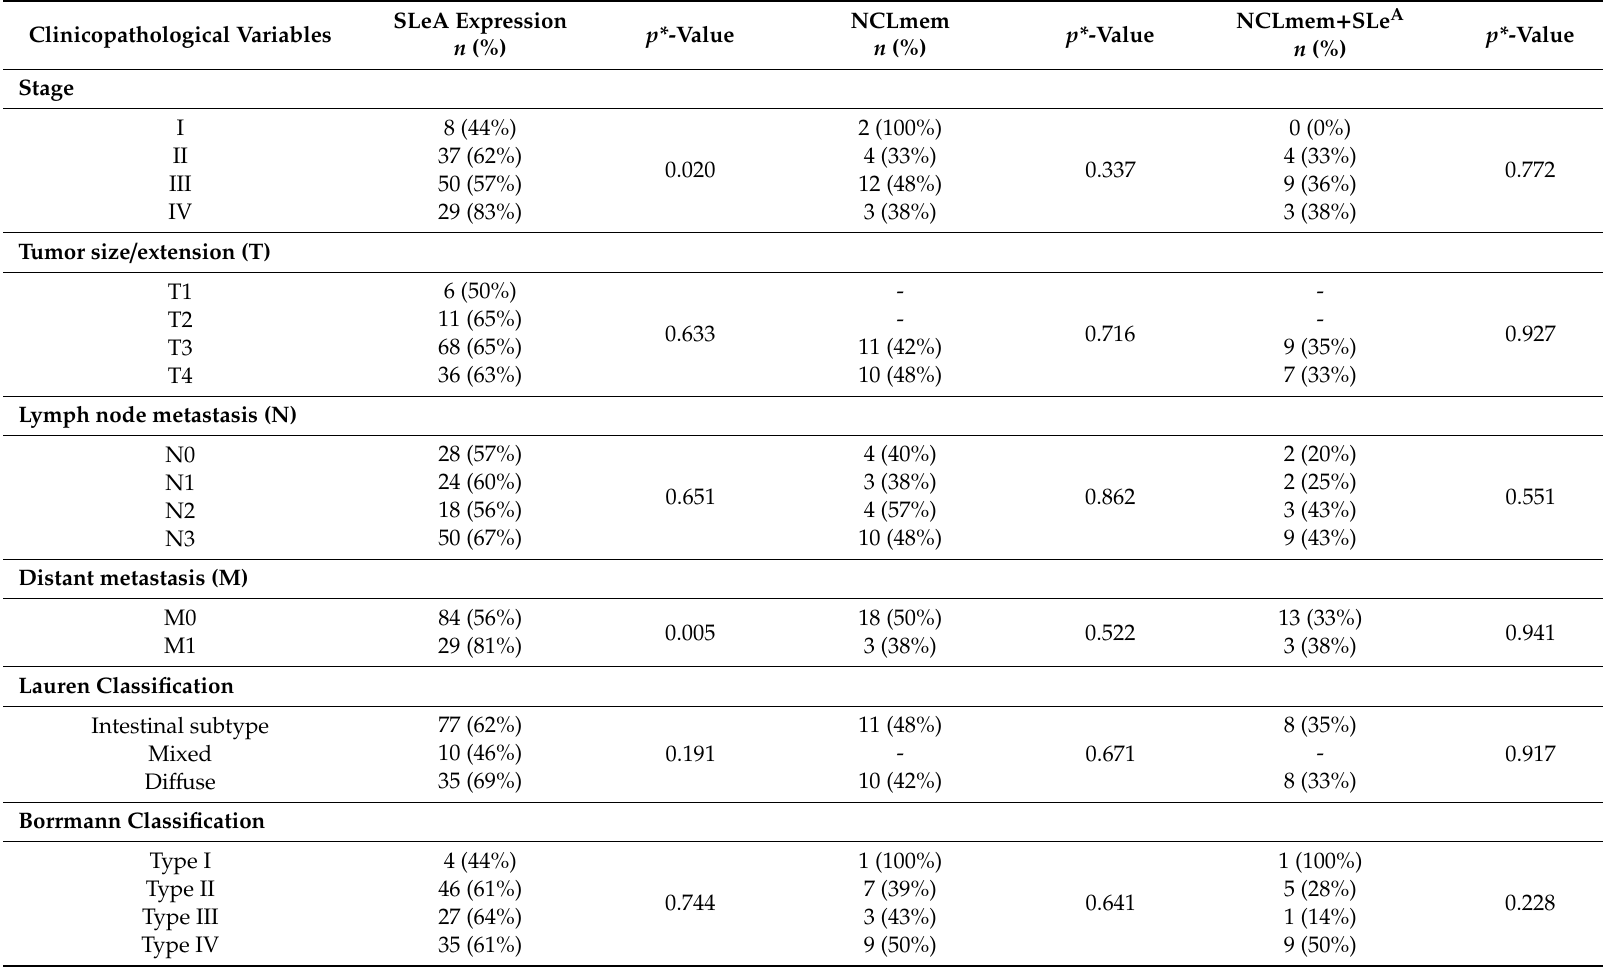
Table 3. Expression of SLeA and NCL at the cell membrane (NCLmem) in GC according to clinicopathological